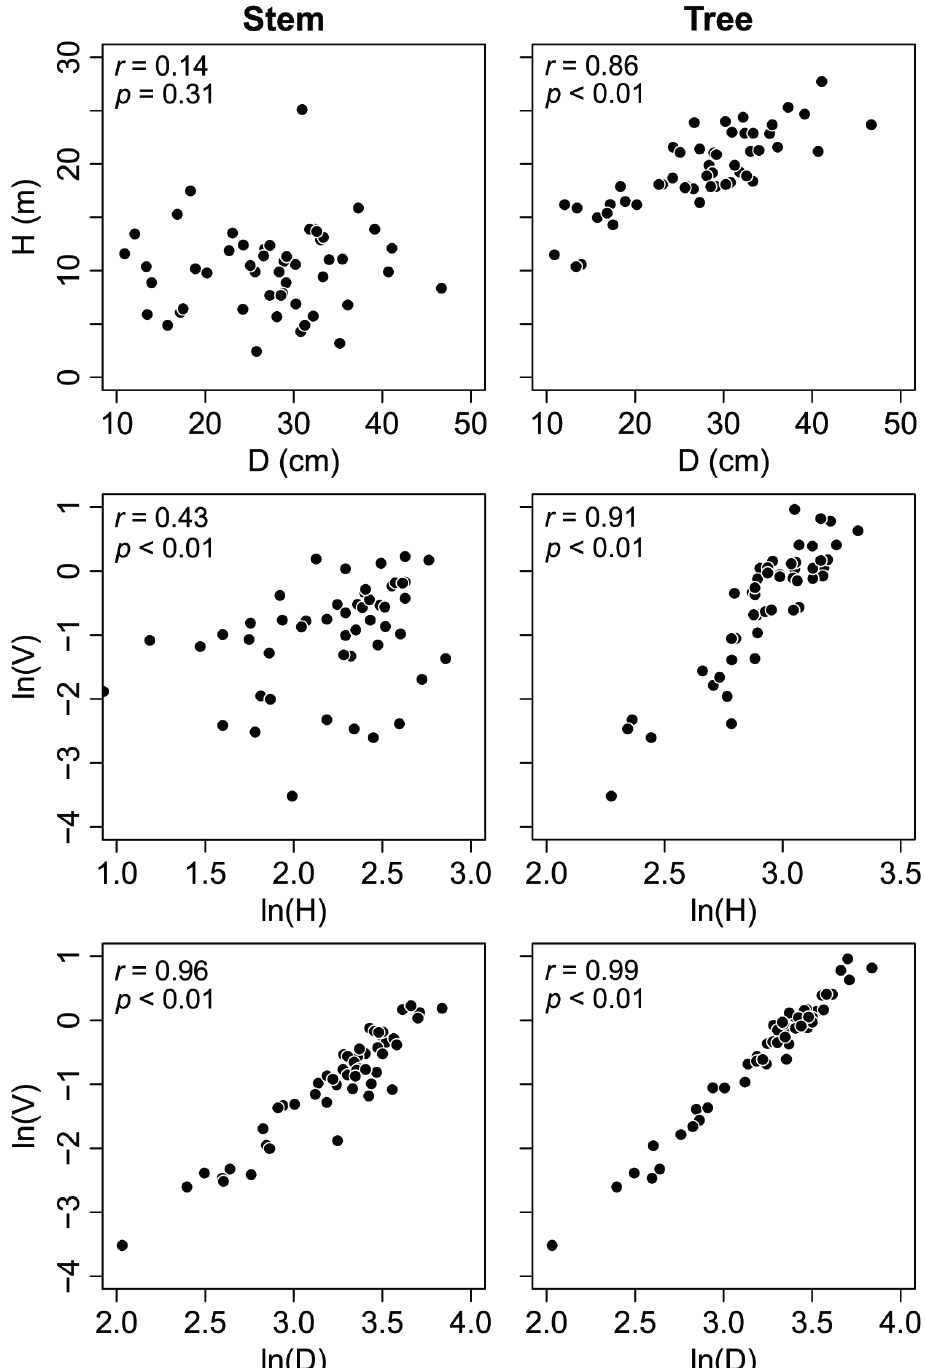
Figure 4 - Relationships between different predictor variables and stem and total volume of H. alchorneoides ( n = 53). r = Pearson’s correlation